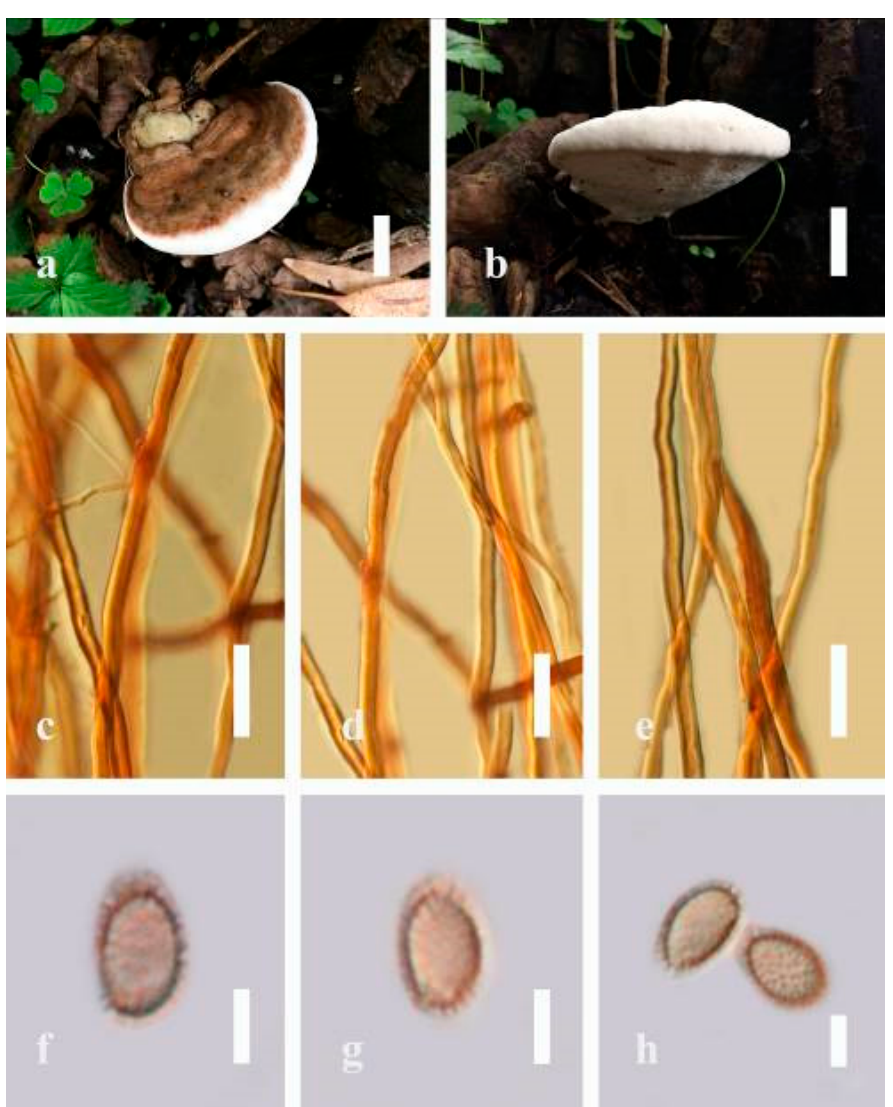
Figure 18. Morphology of Ganoderma gibbosum (MFLU 19-2190): ( a , b ) mature basidiomes; ( c – e ) con- text hyphae as seen in Melzer’s reagent; ( f – h ) basidiospores. Scale bars: ( a , b ) = 2 cm, ( c – e ) = 20 μ m, ( f – h ) = 5 μ m.